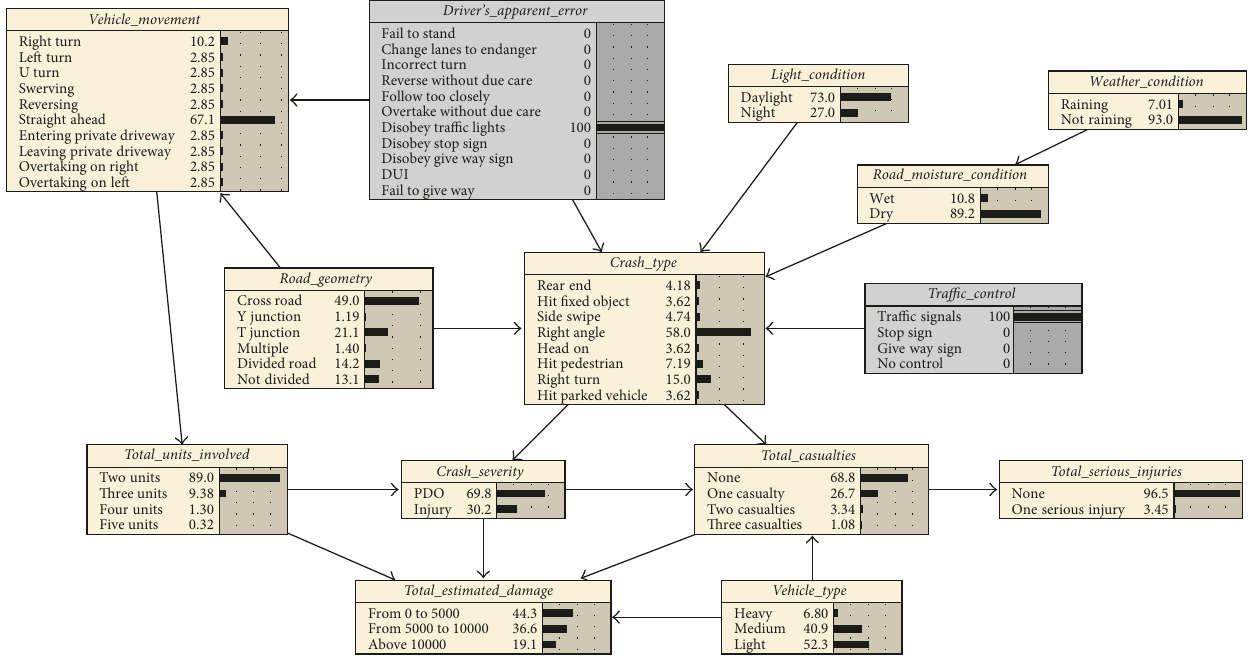
Figure 8: Road accident prediction when the evidence variables are “traffic signals” and “disobey traffic lights.”